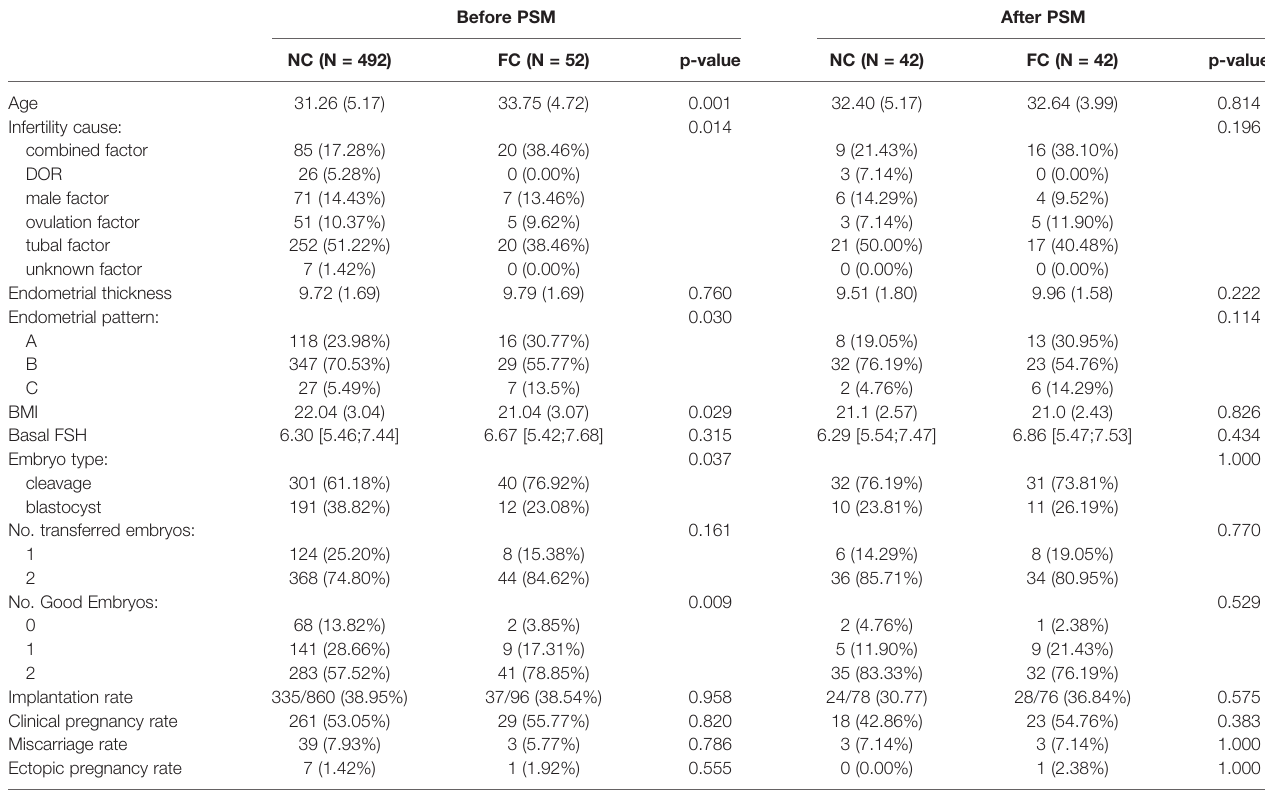
TABLE 3 | Baseline characteristics and pregnancy outcomes between the FC group and the NC group before or after PSM. Before PSM